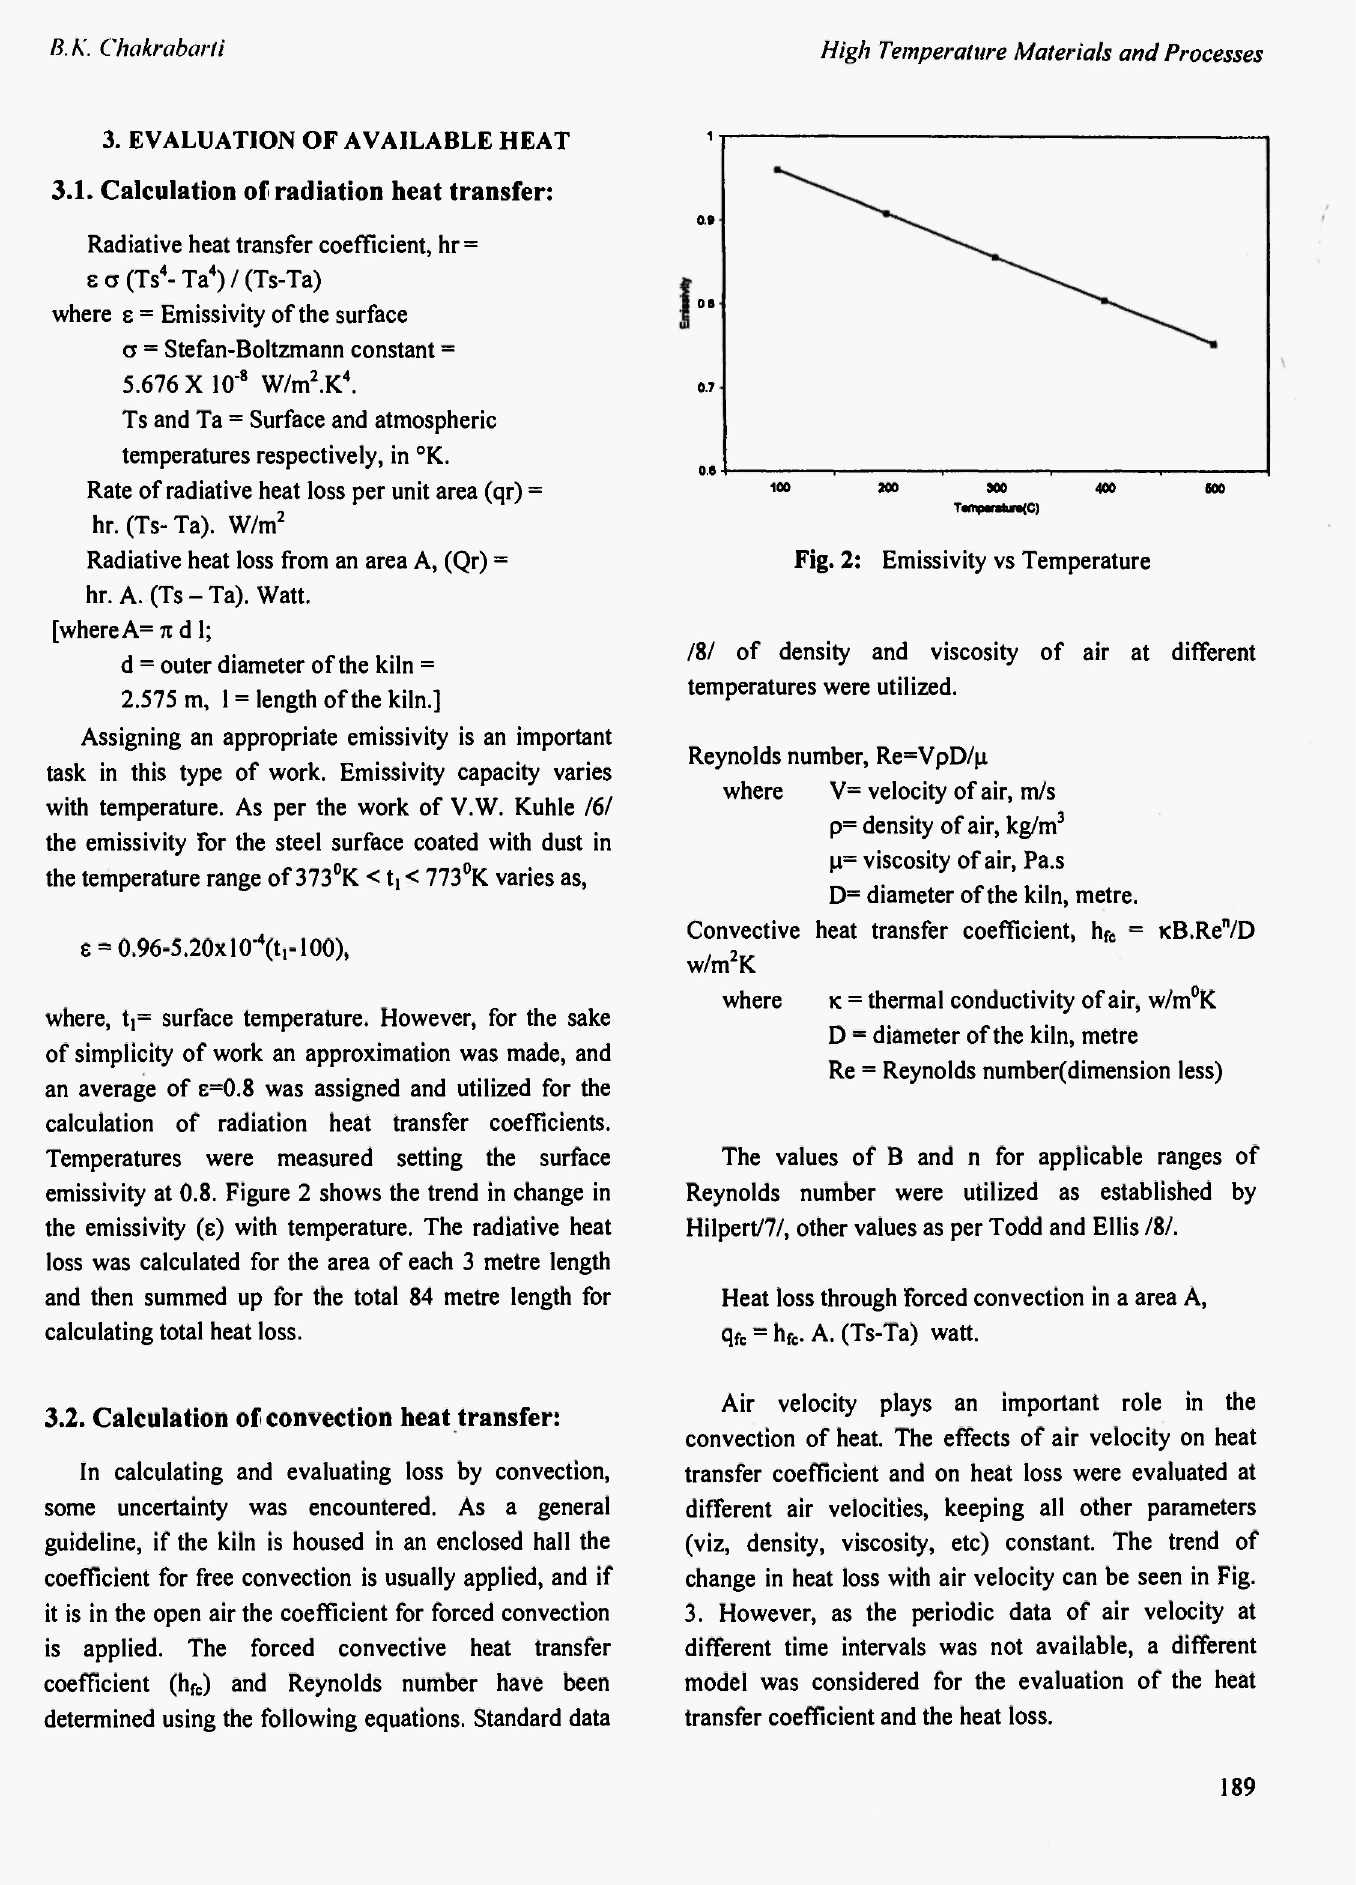
/8/ of density and viscosity of air at different temperatures were